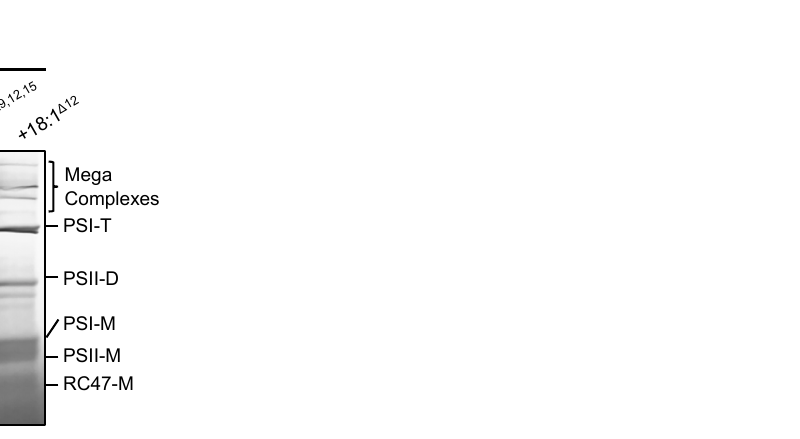
4 of 13 Figure 2. Effect of unsaturated C18 FFAs on electron transfer in PSII. Thylakoid membranes were prepared from cells exposed to strong light at 1500 μ mol photons m − 2 s − 1 at 32 °C without (green bars) or with 18:3 Δ 9,12,15 (brown bars) or 18:1 Δ 12 (light blue bars) at a final concentration of 50 μ mol L − 1 . The electron transfer activity from H 2 O ( a ) or diphenylcarbazide (DPC) ( b ) to 2,6-dichlorophe- nolindophenol (DCIP) was calculated by changes in absorbance at 580 nm due to the reduction of DCIP at 32°C under strong light at 1500 μ mol photons m − 2 s − 1 . To measure the electron transfer rates from DPC to DCIP, the oxygen-evolving complex (OEC) in thylakoid samples was disrupted by incubation with 5 mM NH 2 OH for 5 min on ice. Values are the means ± SD (bars) of three independ- ent experiments. Asterisks indicate statistically significant differences (* p < 0.05; Student’s t -test). 2.2. 18:3 Δ 9,12,15 Destabilizes Photosynthetic Complexes under Strong Light To investigate the effect of 18:3 Δ 9,12,15 on photosynthetic complexes under strong light, we analyzed protein complexes in thylakoid membranes from cells treated with 50 μ mol L − 1 18:3 Δ 9,12,15 under strong light (Figure 3). In cells treated without 18:3 Δ 9,12,15 , exposure to strong light slightly decreased the amount of PSII dimer and PSI trimer, and increased PSI and PSII monomers (Figure 3). By contrast, in cells incubated with 18:3 Δ 9,12,15 under strong light, mega-complexes and the amount of PSI trimer and PSII dimer and monomer com- plexes decreased greatly, and the amount of PSI monomer and CP43-less PSII monomer complexes (RC47) increased (Figure 3). Therefore, 18:3 Δ 9,12,15 destabilized and dissociated